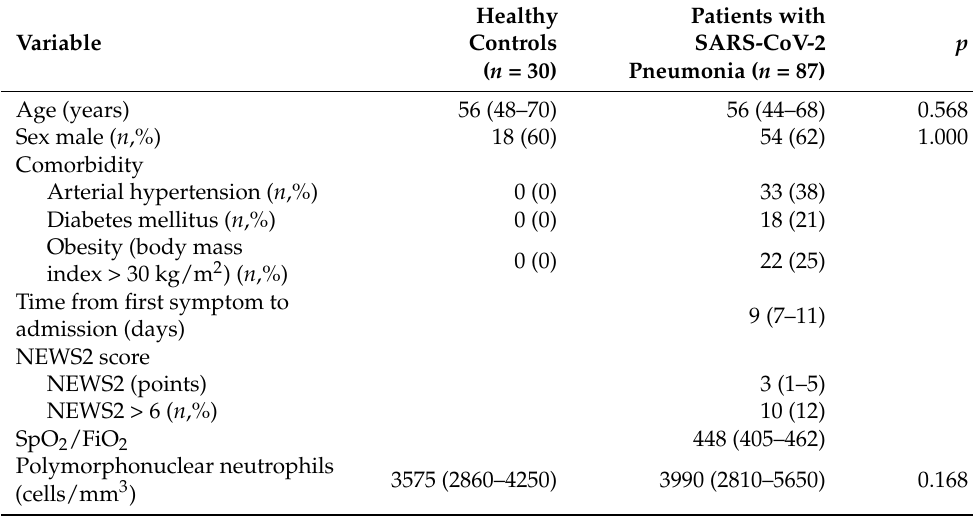
Table 1. Baseline characteristics of healthy controls and patients hospitalized by COVID-19